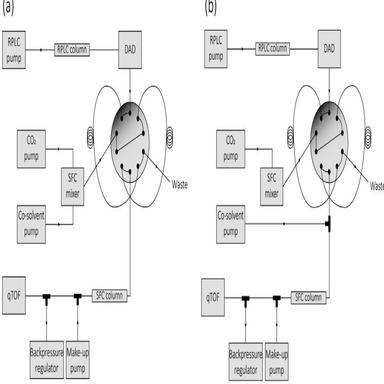
Schematic representation of the on-line RPLC x SFC setup. (a) standard configuration and (b) new configuration.